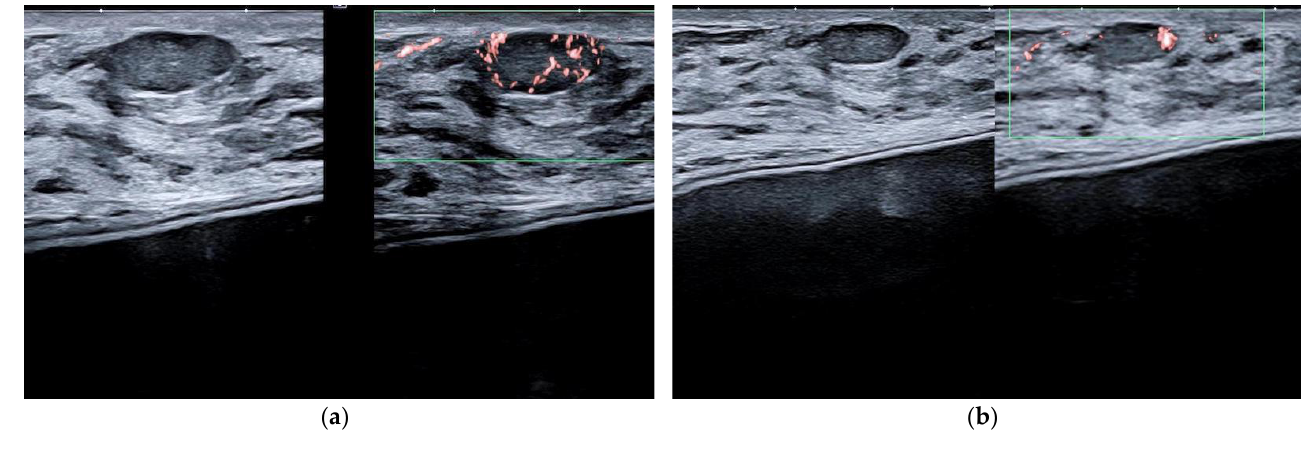
Figure 9. Fibroadenoma in a patient with a dual-plane breast implant. The quite superficial nodule is better depicted in its echotexture and vascularization by power-Doppler imaging when imaged at 22 MHz ( a ) than at 15 MHz ( b ).